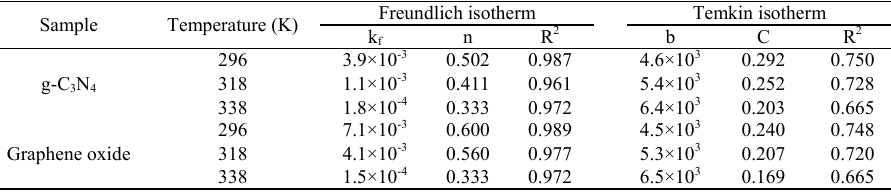
Table 2. Adsorption parameters of the prepared samples 296, 318 and 338